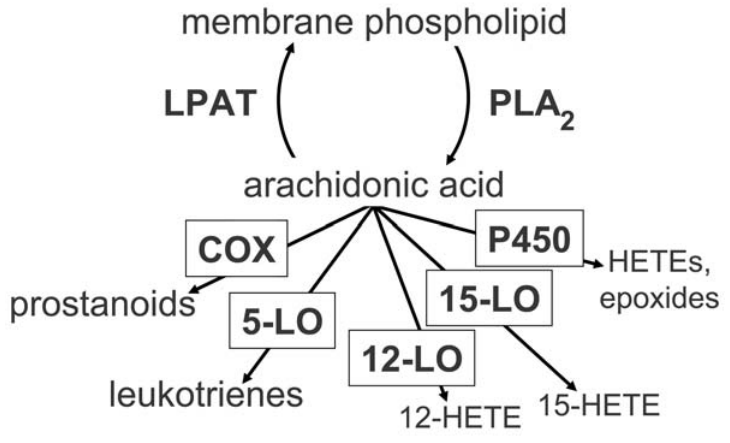
FIGURE 1. Overview of eicosanoid synthesis. AA is released from membrane phospholipid by PLA 2 enzymes and may be reacylated into phospholipid by lysophospholipid acyltransferase (LPAT). Free AA is metabolized by different enzymes, including COX, 5-LO, 12-LO, 15-LO, and cytochrome P450, to produce the different